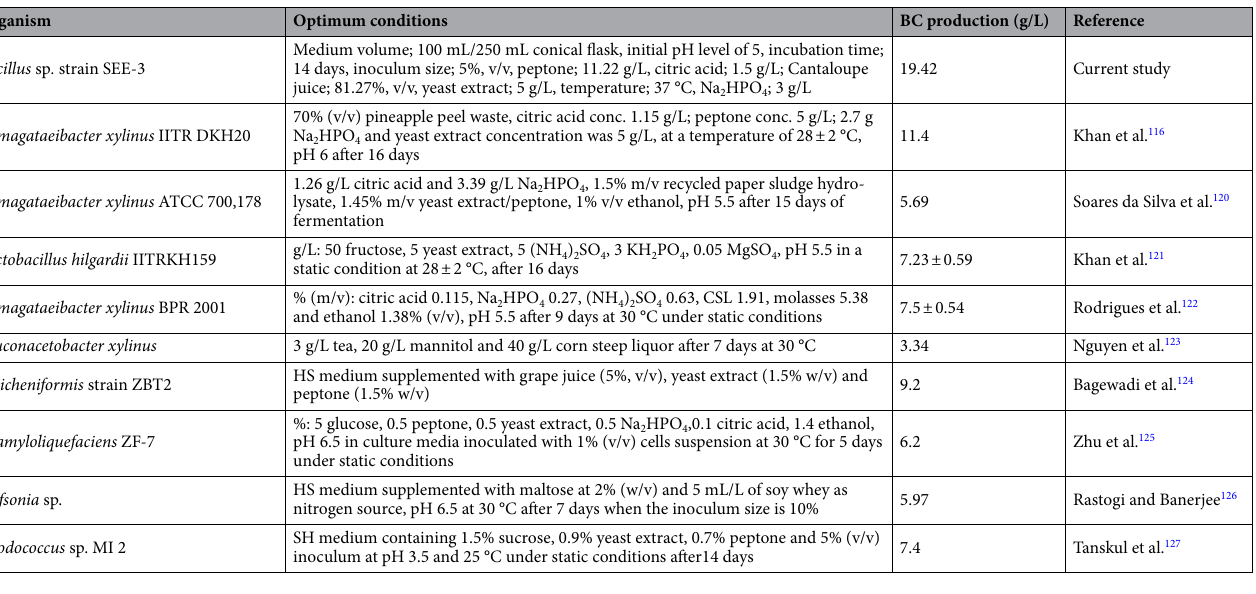
Table 6. A comparison between Bacillus sp . strain SEE-3 and some BC producers in terms of BC production and optimum